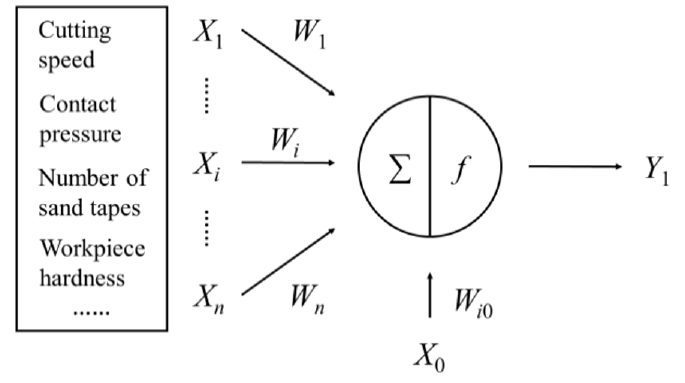
Figure 1. Neuron